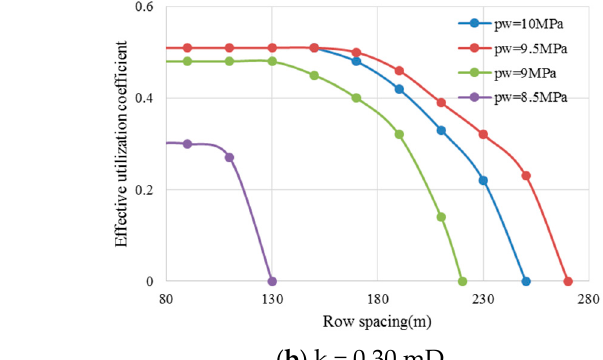
Figure 22. The relationship between the production rate and the row spacing.